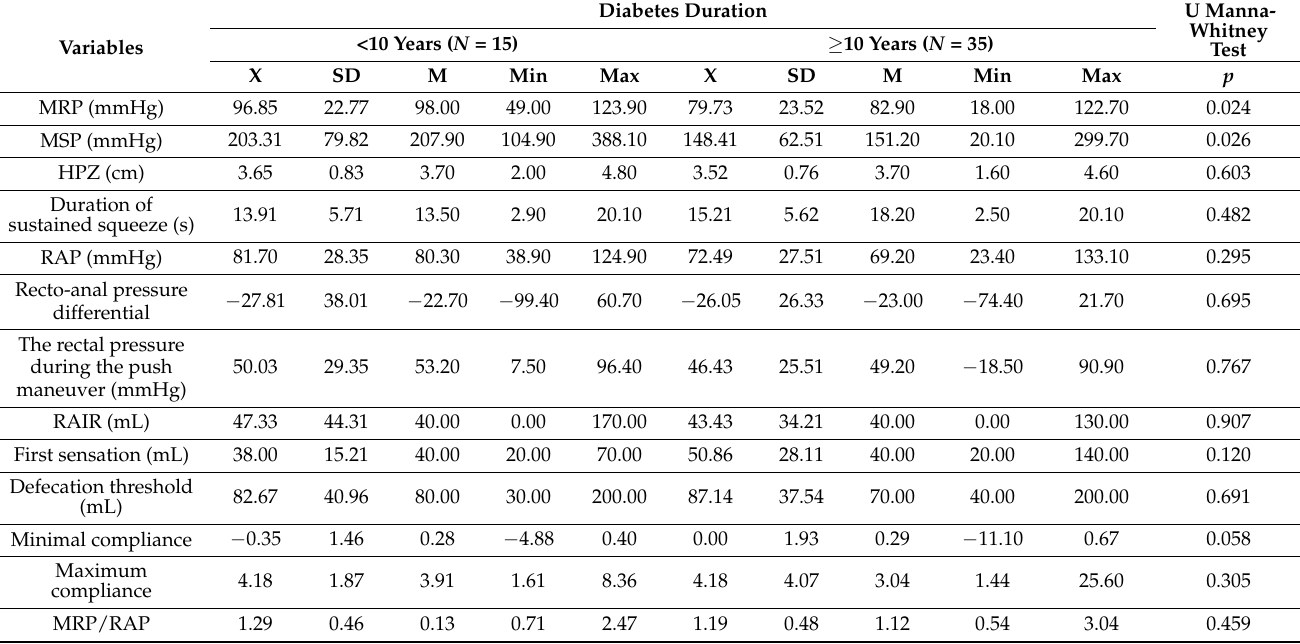
(Table 10). The MRP and MSP values of patients with shorter duration of diabetes were comparable to the results of the control subjects. Table 10. Manometric parameters in patients depending on the duration of